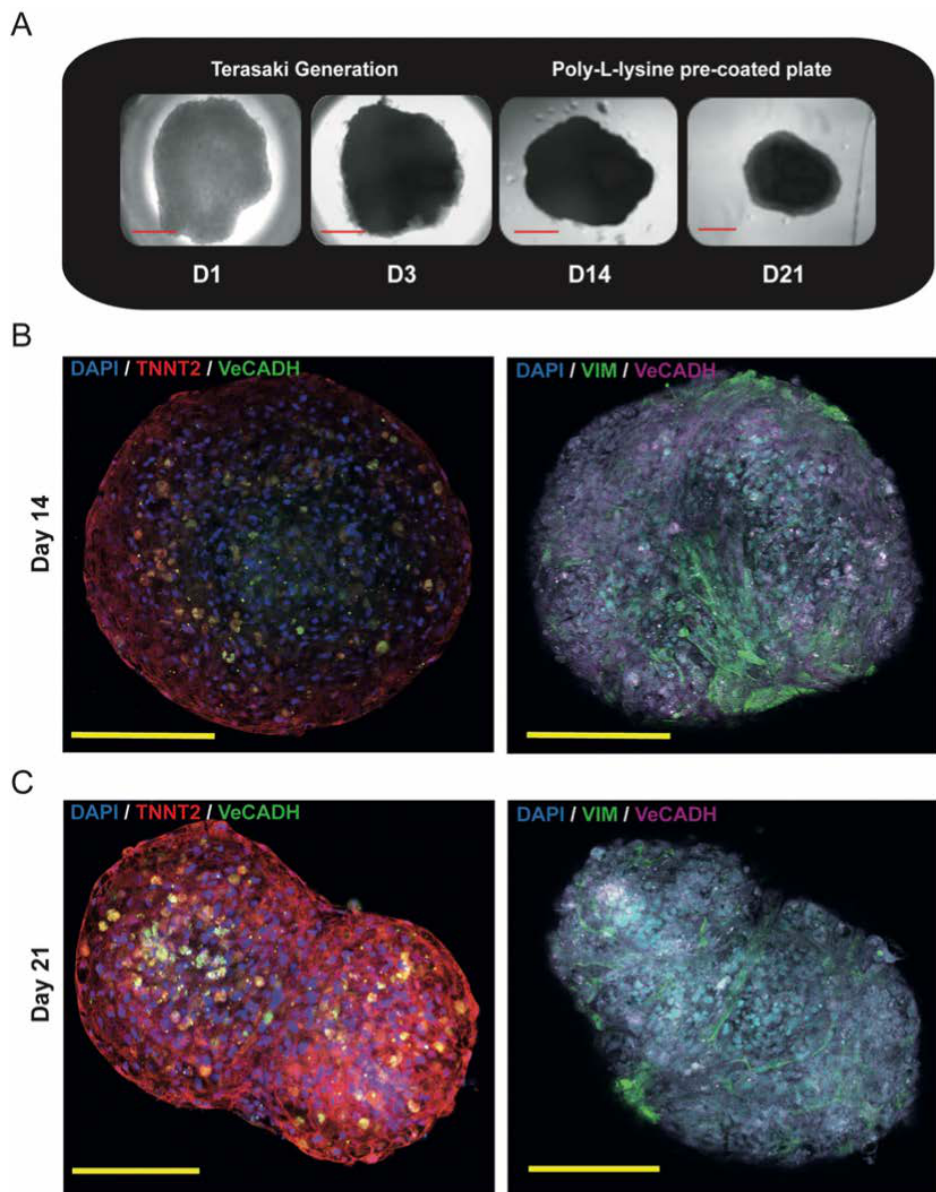
Figure 3. Modelling Adult Human Heart Organoids. ( A ) Generation of contractile cardiac organoids (Cor-Oids) containing Cor.4U-CMs, HCMECs and HCF at 3:5:2 cell ratio using Terasaki plates showed the formation of compact ball-like shapes after 21 days of culture. ( B ) Immunofluorescence staining images of Cor-Oids after 14 days of culture, labelled with cardiac-specific troponin (TNNT2), vascular cadherin (VeCADH) and vimentin (VIM), showing organoids with a lack of defined cardiac structures (T-tubules and sarcomeres). ( C ) Immunofluorescence staining images of Cor-Oids after 21 days of culture, labelled with cardiac-specific troponin (TNNT2), vascular cadherin (VeCADH) and vimentin (VIM), showing CMs migration toward the organoid core, promoting the formation of cardiac filament-like structures. Scale bars = 200 µm.